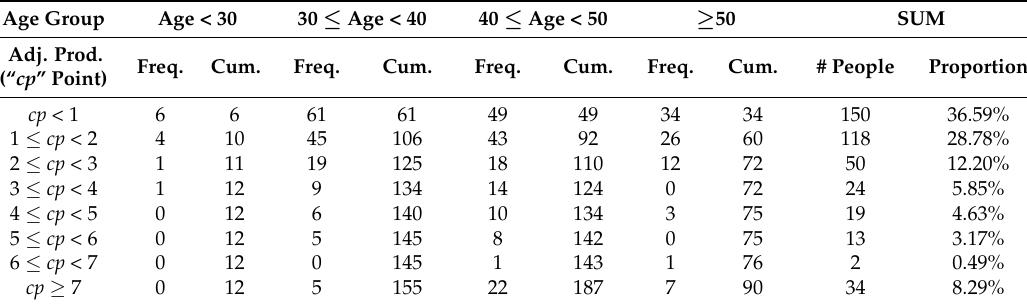
Table A3. Distribution of authors by age group and relative productivity (“ cp